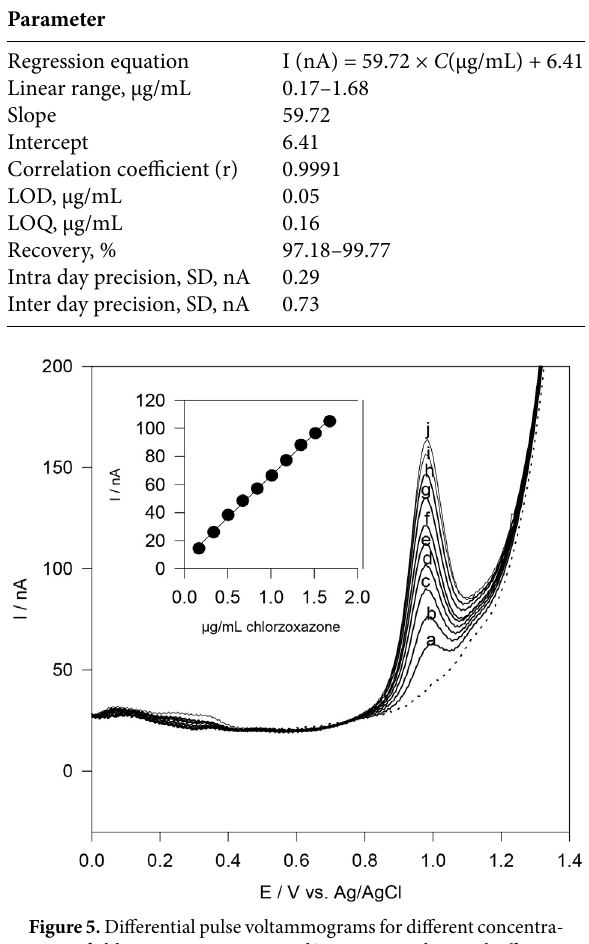
Table 1. The analytical parameters for the proposed differential pulse anodic voltammetric method for the determination of chlor- zoxazone using carbon paste electrode.